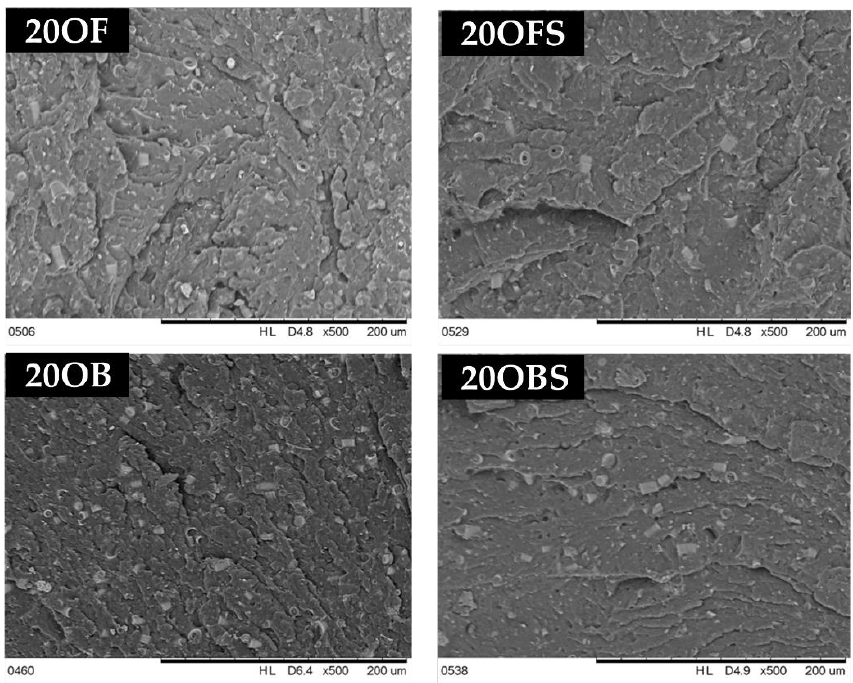
Figure 24. An SEM image of a composite containing 20% of basic diatomaceous earth.